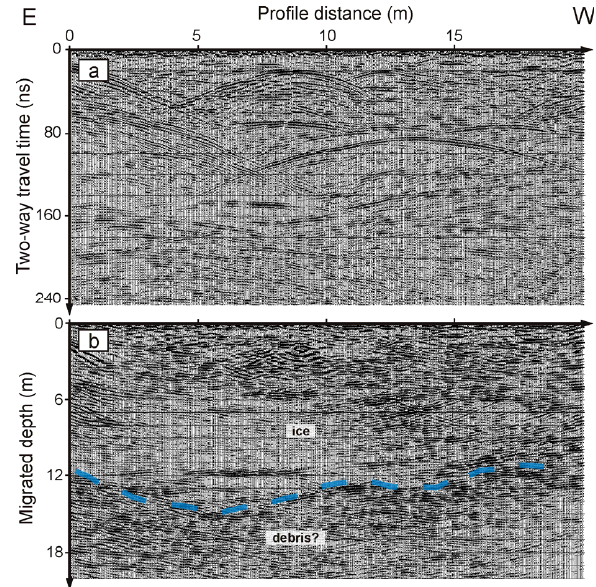
Figure 5: Radargram sections (a) from Dachstein-Rieseneishöhle using the 200 MHz antenna. The base of the ice is better imaged in the migrated section (b). Fig. 5. Radargram sections (a) from Dachstein-Rieseneish¨ohle us- ing the 200MHz antenna. The base of the ice is better imaged in the migrated section (b) .